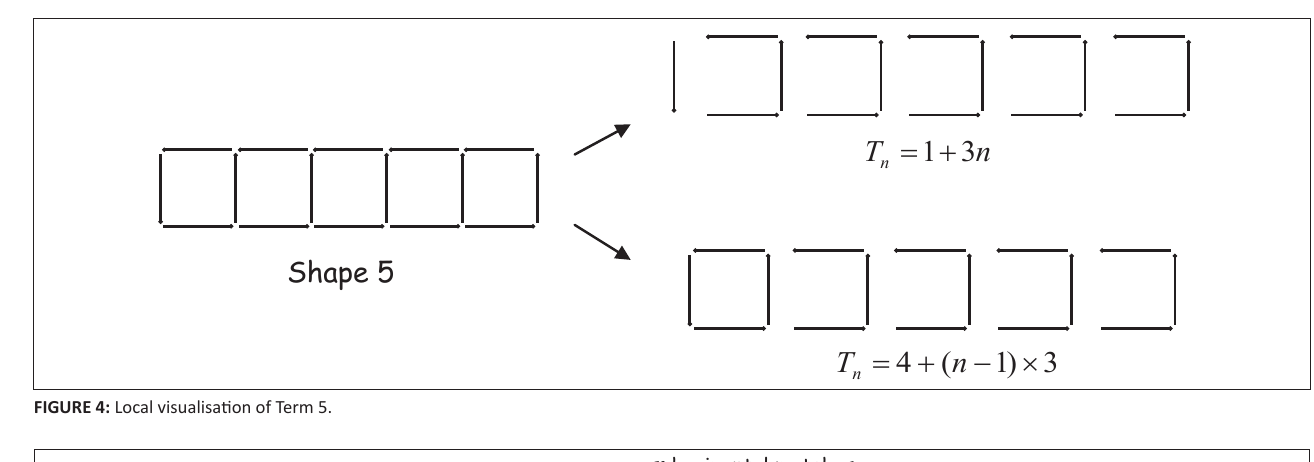
FIGURE 4: Local visualisation of Term 5.